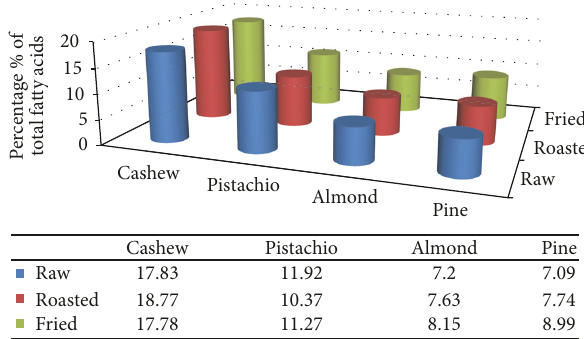
Figure 1: Saturated fatty acids%.